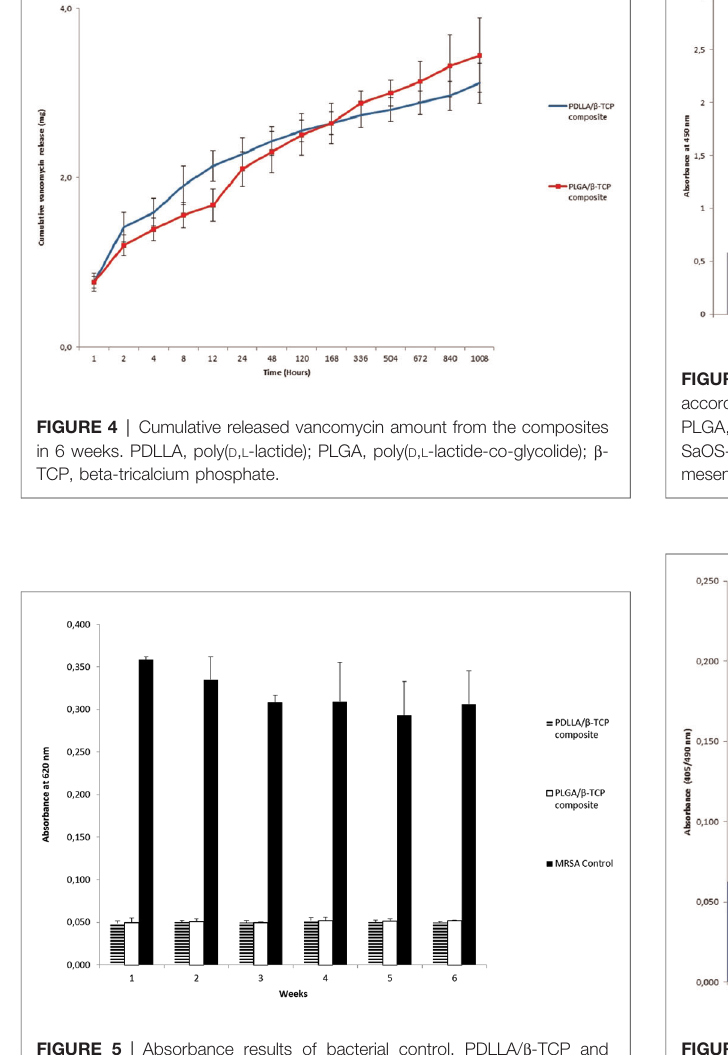
FIGURE 5 | Absorbance results of bacterial control, PDLLA/ β -TCP and PLGA/ β -TCP composites at 620 nm (weeks are de fi ning the time point of drug release media collected from release studies). PDLLA, poly( D , L -lactide); PLGA, poly( D , L -lactide-co-glycolide); β -TCP, beta-tricalcium phosphate; MRSA, methicillin-resistant Staphylococcus aureus .